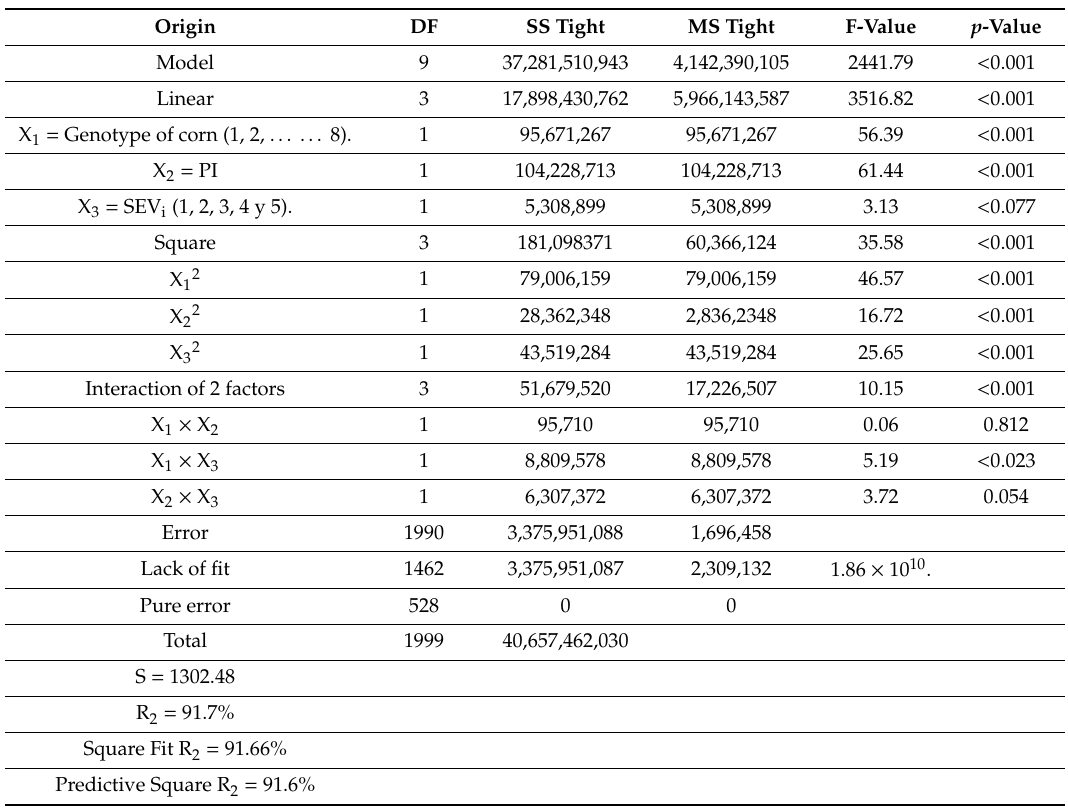
Table 3. Response surface regression analysis of the potential yield per hectare (RPH) vs. the corn genotype, incidence percentage (PI), and severity measurement (SEV i